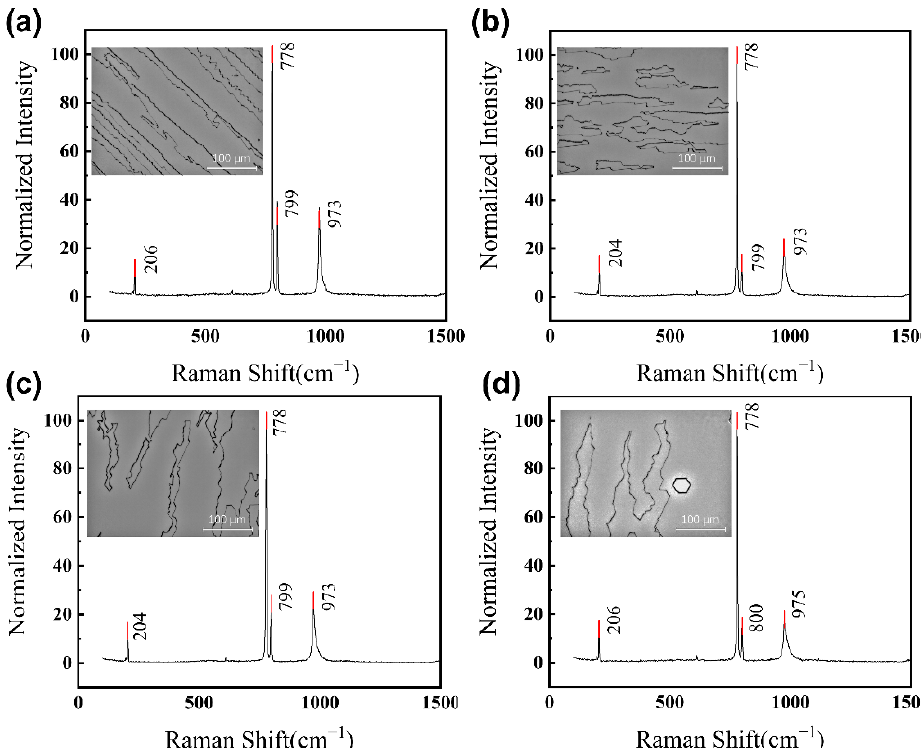
Figure 1. Nomarski photographs and Raman spectra of the epitaxial layer surface with different growth temperatures (T g ). T g is ( a ) 1550 °C, ( b ) 1580 °C, ( c ) 1600 °C, and ( d ) 1650 °C.